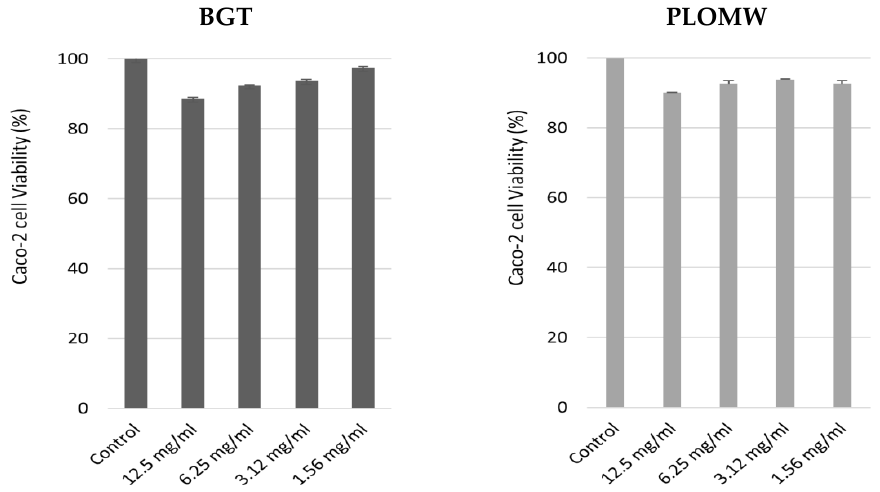
Figure 5. Effect of BTG and PLOMW on Caco-2 cells viability.